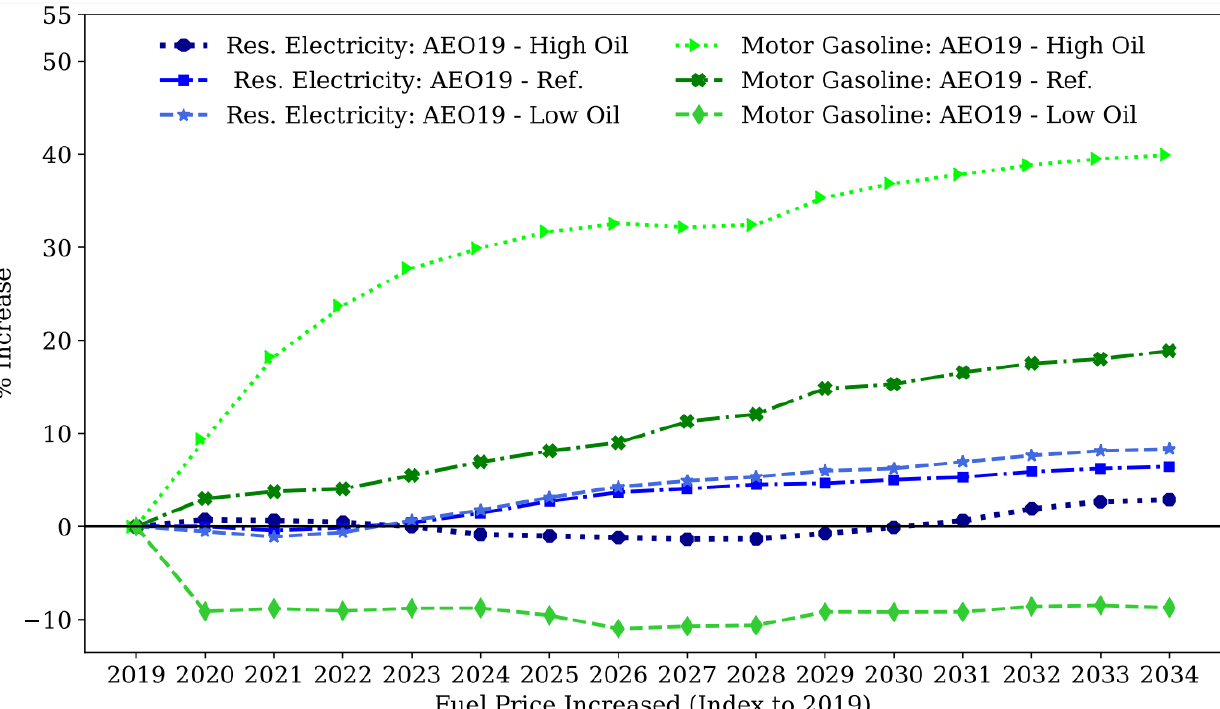
Figure 3. Projected residential electricity and gasoline costs for 15-years period.